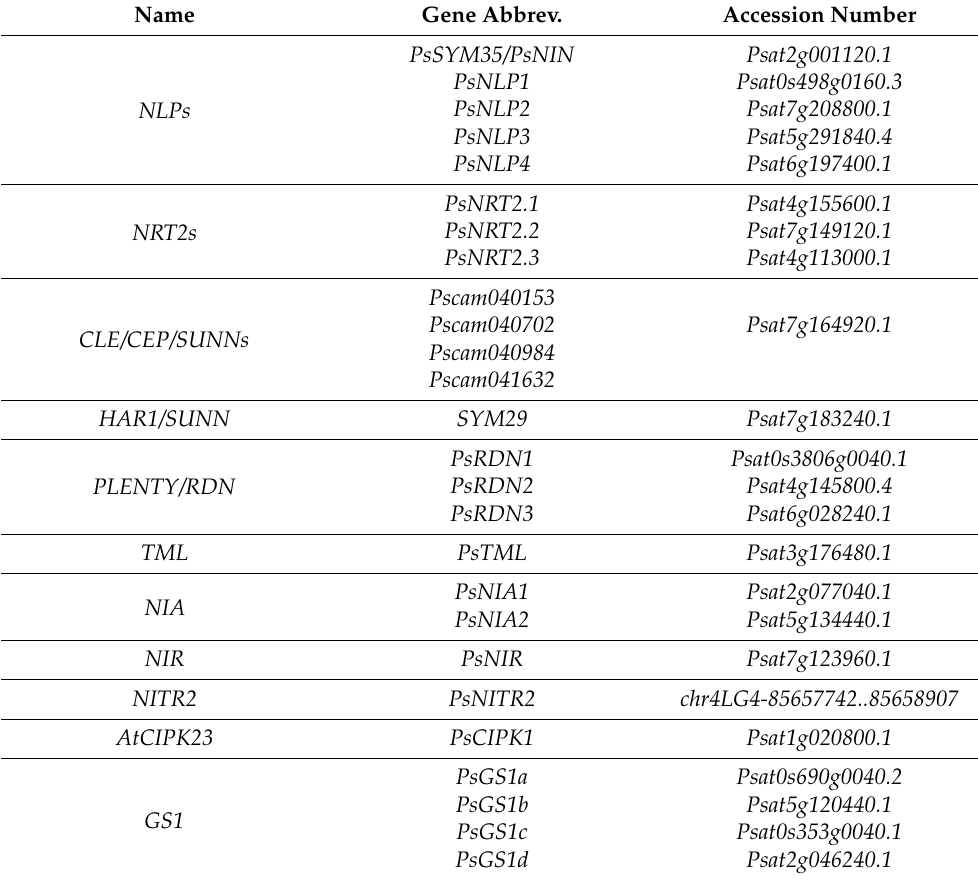
Table 1. Pea genes involved in nodulation and NO 3 −